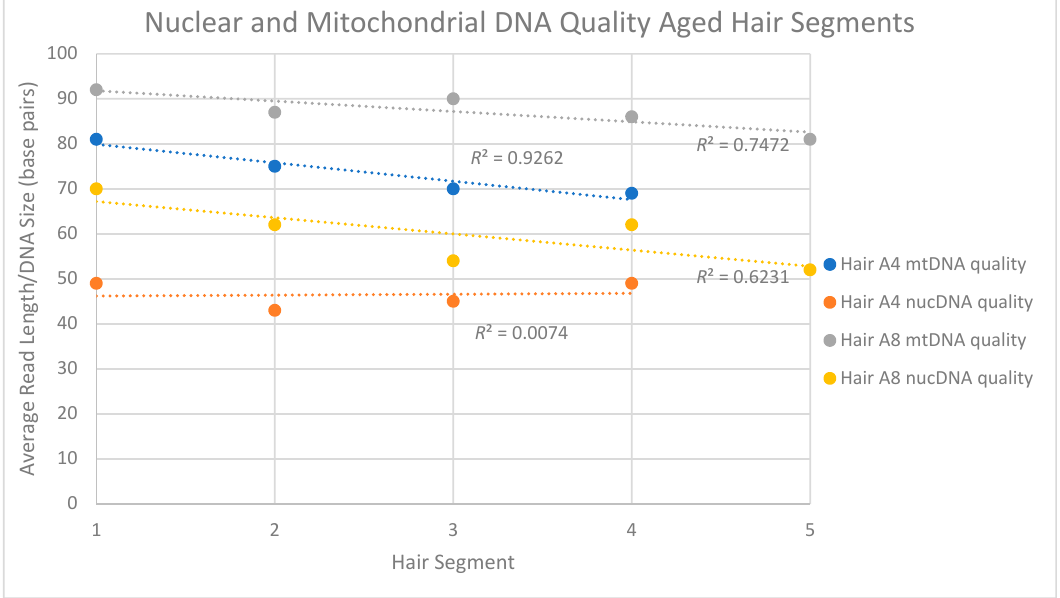
Figure 5. Nuclear and mitochondrial DNA quality (i.e., read length) for segments of two aged hairs. For hair A4*, the four 5 cm segments spanned 35 cm of hair. For A8*, the five 5 cm segments spanned 25 cm of hair. For each segment, and regardless of the hair sample, the average size of the mtDNA fragments was larger than the average size of the nuclear DNA fragments. In addition, with the exception of the hair A4 nuclear DNA, fragment sizes tended to decrease along the length of the hair shaft.